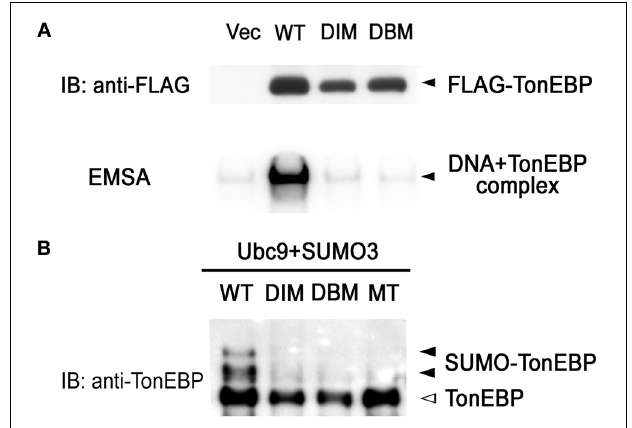
FIGURE 4 | DNA binding is required for sumoylation of TonEBP. (A) HEK293 cells were transfected with empty vector (Vec) or one the following FLAG-tagged constructs: WT, wild type; DIM (dimer interface mutant), F464A/I466A; DBM (DNA binding mutant), T298A/E299A/R302A. Top: Cell lysates were immunoblotted for FLAG. Bottom: EMSA was performed using the cell lysates and 1nM of [ 32 P]-TonE. Positions of FLAG-TonEBP and DNA bound TonEBP are indicated. (B) HEK293 cells were transfected with Ubc9, SUMO3, and each of the constructs shown in (A) and MT (K556R/K603R mutant, see Figure 3 ). The cells were cultured for 4h in hypertonic medium and immunoblotted for TonEBP.